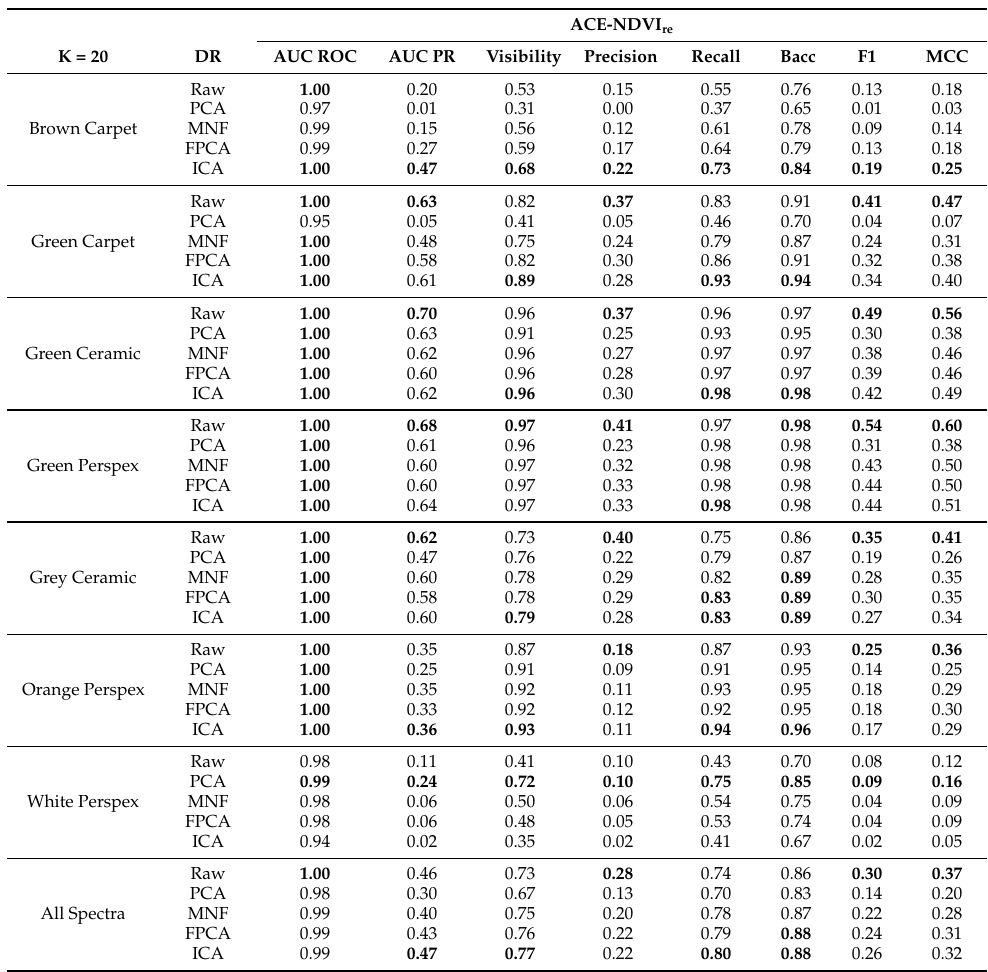
Table 8. Average performance measures for each target in the Selene dataset with NDVI re -based spatial DR applied using the ACE